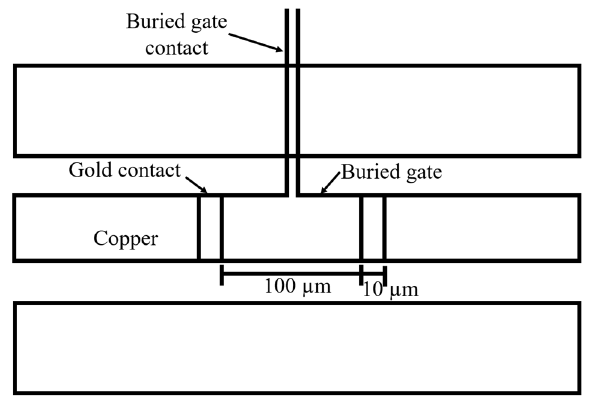
Figure 6. Diagram of the DUT measurement structure with the buried gate, with a contact width of 3 μ m, length of 437 μ m, and a square contact pad with a side of 150 μ m.